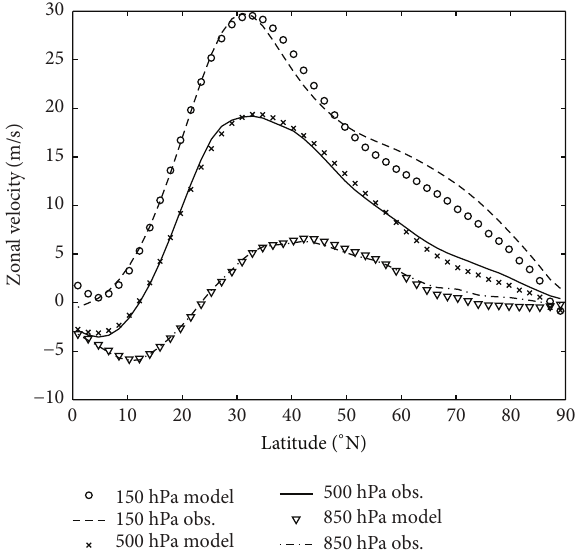
Figure 3: Modeled and observed time-mean zonal wind profiles (ms −1 ) for the three model levels and corresponding vertical layers,